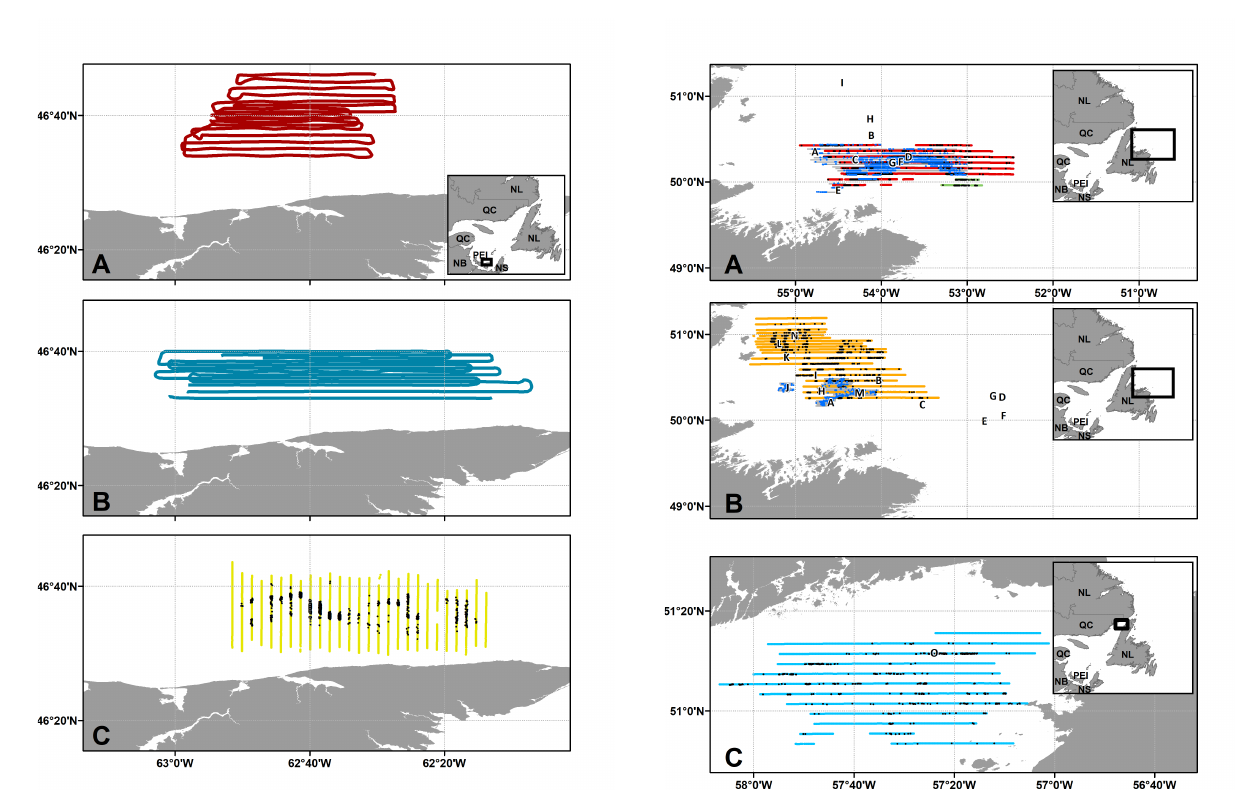
Figure 4. Survey transects during the March 6 (A) and March 7 (B) visual surveys, and March 7 photographic survey (C). Black dots indicate the location of seals during the photographic survey.